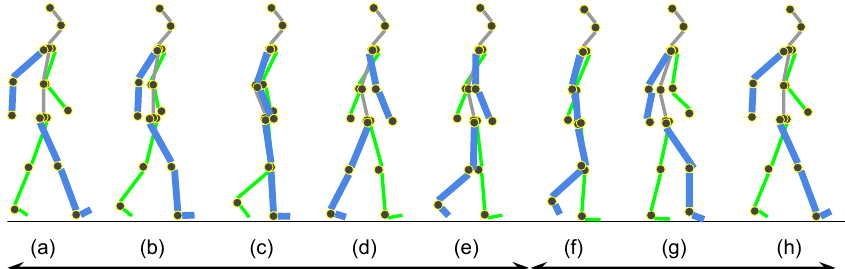
Figure 5. Human gait cycle. ( a ) Initial contact, ( b ) Loading response, ( c ) Mid-stand, ( d ) Terminal stance, ( e ) Pre-swing, ( f ) Initial swing, ( g ) Mid-swing, ( h ) Terminal swing. The stance phase is defined from ( a ) to ( e ). The swing phase is from ( f ) to ( h ). The initial contact and the terminal swing is the same event with a different